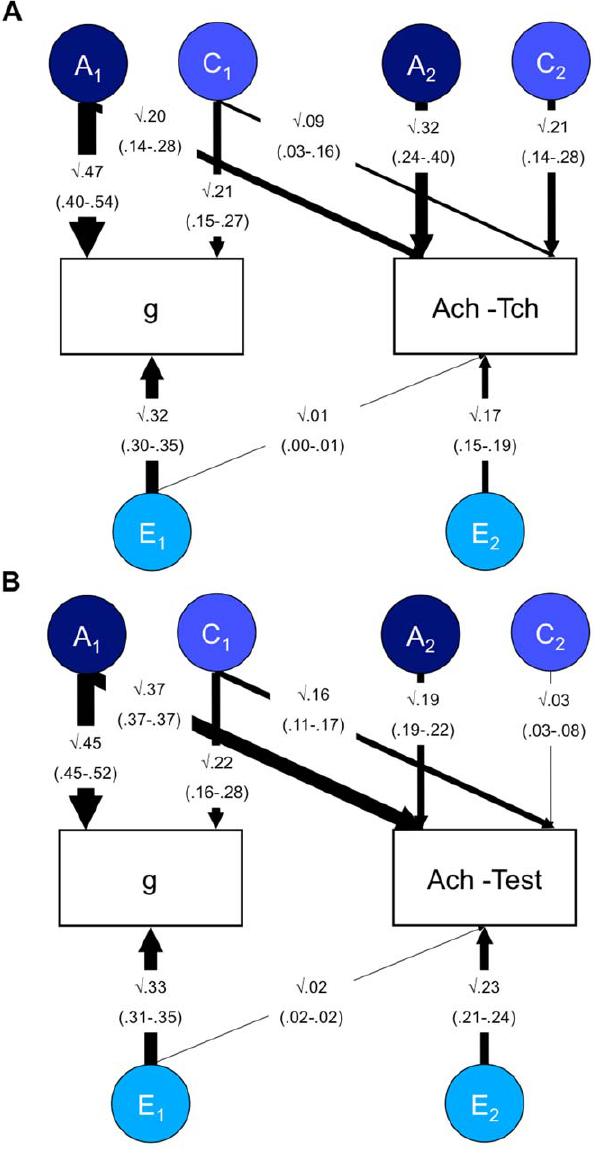
Figure 2. Bivariate analysis of 10 and 12-year achievement. Panel A= Teacher-rated achievement at 10 and 12 years. Panel B= Test achievement at 10 and 12 years. Ach-Tch = Teacher-rated achieve- ment; Ach-Test = test achievement; A= additive genetic; C= Shared environment; E= Non-shared environment. The figures represent the results from a standardized Cholesky decomposition of twin data. 95% confidence intervals of the path estimates are shown in parentheses. The first factors assess genetic (A 1 ), shared (C 1 ) and non-shared environmental (E 1 ) influences on 10-year achievement, some of which may also influence 12- year school achievement. The second factor estimates influences on 12-year achievement that are independent of the influences on 10-year achievement (A 2 , C 2 and E 2 ). Results indicate significant residual genetic influence on 12-year school achievement, even when the genetic and environmental co-variance with previous achievement has been removed (see the A 2 path estimate).